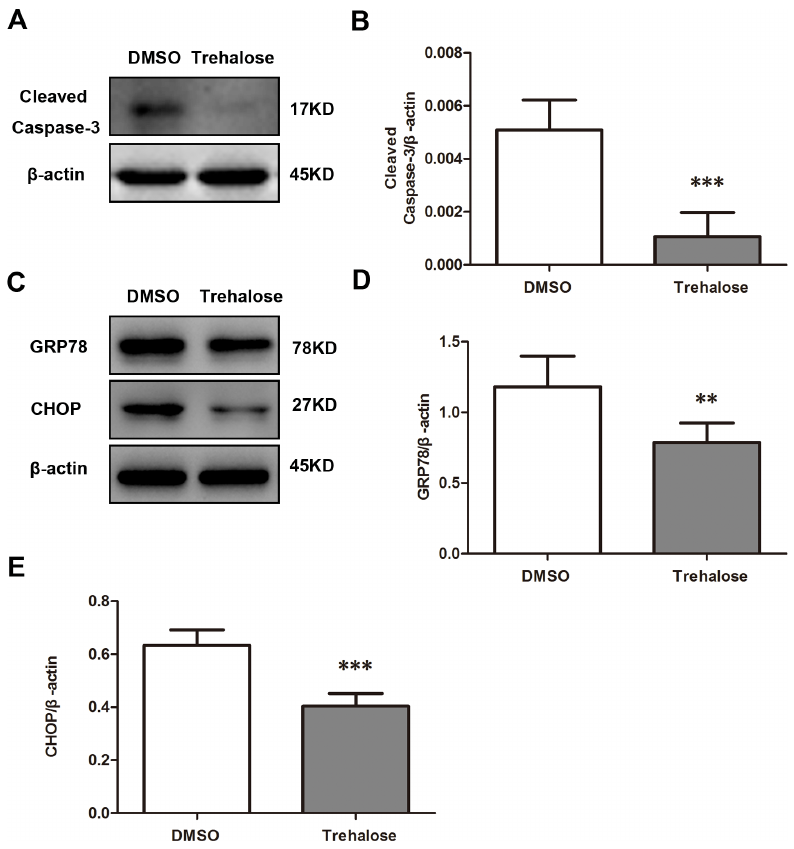
Fig 2. Effect of trehalose on apoptosis and ERS in cryopreserved valve cells. (A and B) Western blotting using a cleaved caspase-3 antibody on cryopreserved valve cells treated with trehalose (0.1 mol/L) or DMSO for 16 weeks. (C, D and E) Western blotting using GRP78 and CHOP antibodies on cryopreserved valves treated with trehalose (0.1 mol/L) for 16 weeks. Data are expressed as the mean ± SD ( n = 20 per group). (cid:3)(cid:3) P < 0.01, (cid:3)(cid:3)(cid:3) P < 0.001 versus the DMSO